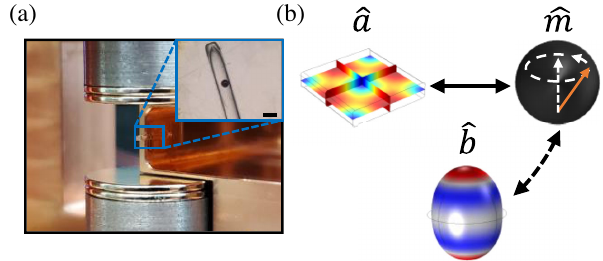
FIG. 1. Experimental setup. (a) Photograph of half of the microwave cavity, made from oxygen-free copper. The YIG sphere is placed — free to move — within a glass capillary, inner dimension of approximately 300 μ m. A set of permanent neo- dymium magnets attached to a pure iron yoke provides the bias magnetic field, and a solenoid (not shown) allows the bias field to be varied dynamically. Inset: Optical micrograph of the YIG sphere inside of the glass capillary. Scale bar is 500 μ m. (b) Schematic of the coupled magnomechanical system. ˆ a , numerical simulation of the TE 101 microwave magnetic field distribution. ˆ m , schematic representation of the Kittel magnon ˆ b , numerically simulated mode within the spherical YIG sample. displacement of the mechanical mode that has the strongest magnomechanical coupling to the Kittel mode. The solid line indicates linear magnon-photon coupling, while the dashed line represents parametric magnon-phonon